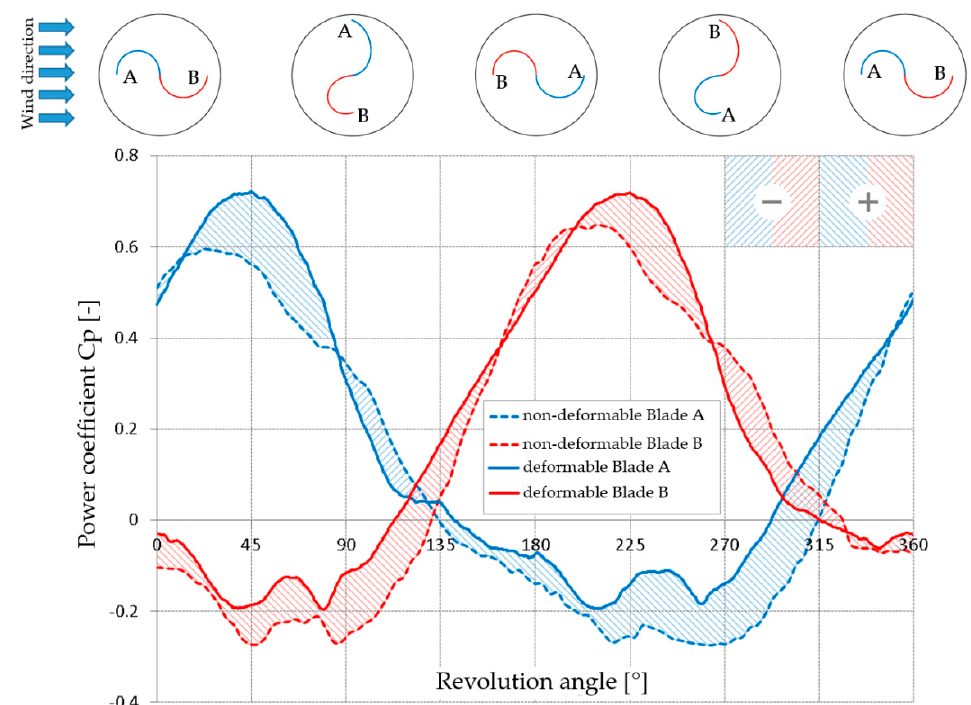
Figure 9. Comparison of the averaged values of the power coe ffi cient Cp for each rotor blade for one revolution of the rotors with non-deformable and deformable blades. Subsequent positions of the turbine illustrated in the schemes above the graph correspond to the turbine revolution